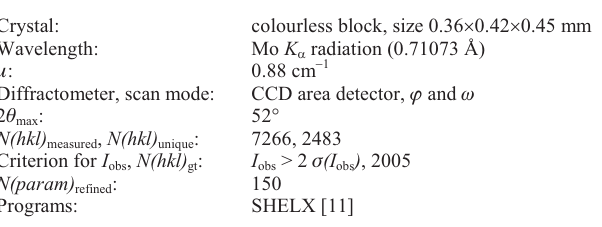
Table 1. Data collection and handling.